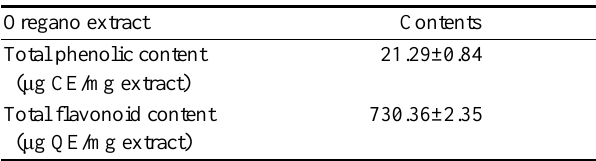
Table 4. DPPH radical scavenging activities (%) of dried oregano extracts